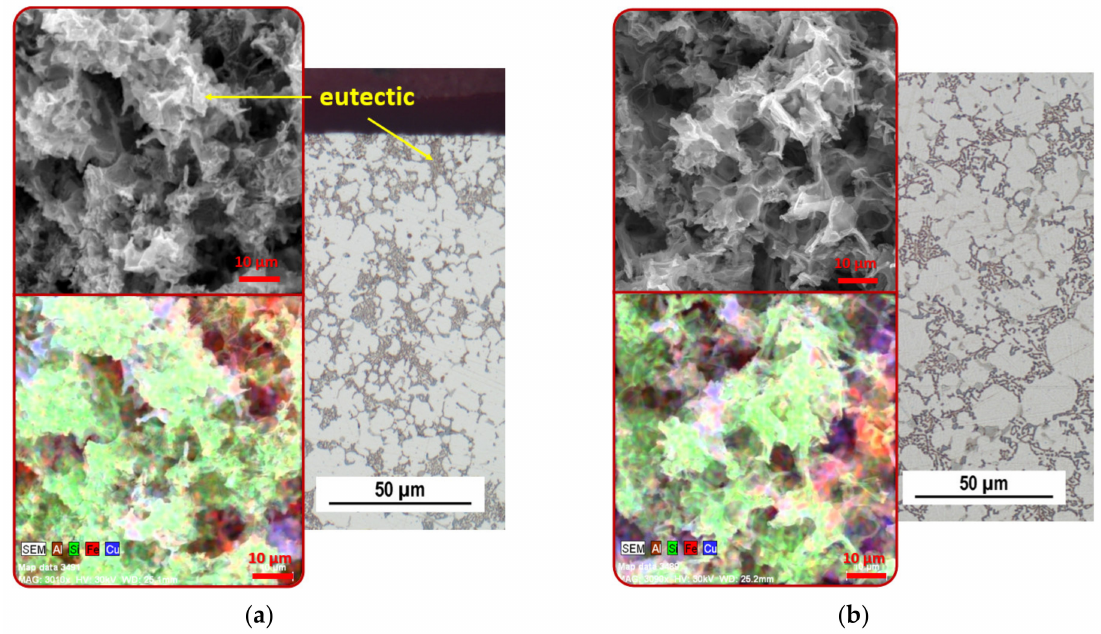
Figure 6. Images of the structure of the Z75 alloy casting in the cast state; OM, SEM: ( a ) surface region; ( b ) central region. The highest amount of returnable material (90%) in the Z90 alloy batch led to the crystallization of coarsely irregular parts of eutectic Si with an undirected distribution in the central region of the specimen (Figure 7b). As in the case of the Z75 alloy, the surface part of the specimen is characterized by finer, and in some places thicker, sharp-edged particles of eutectic Si (Figure 7a). Due to the increase in the amount of returnable material to 75% and 90%, there was also a decrease in phases rich in